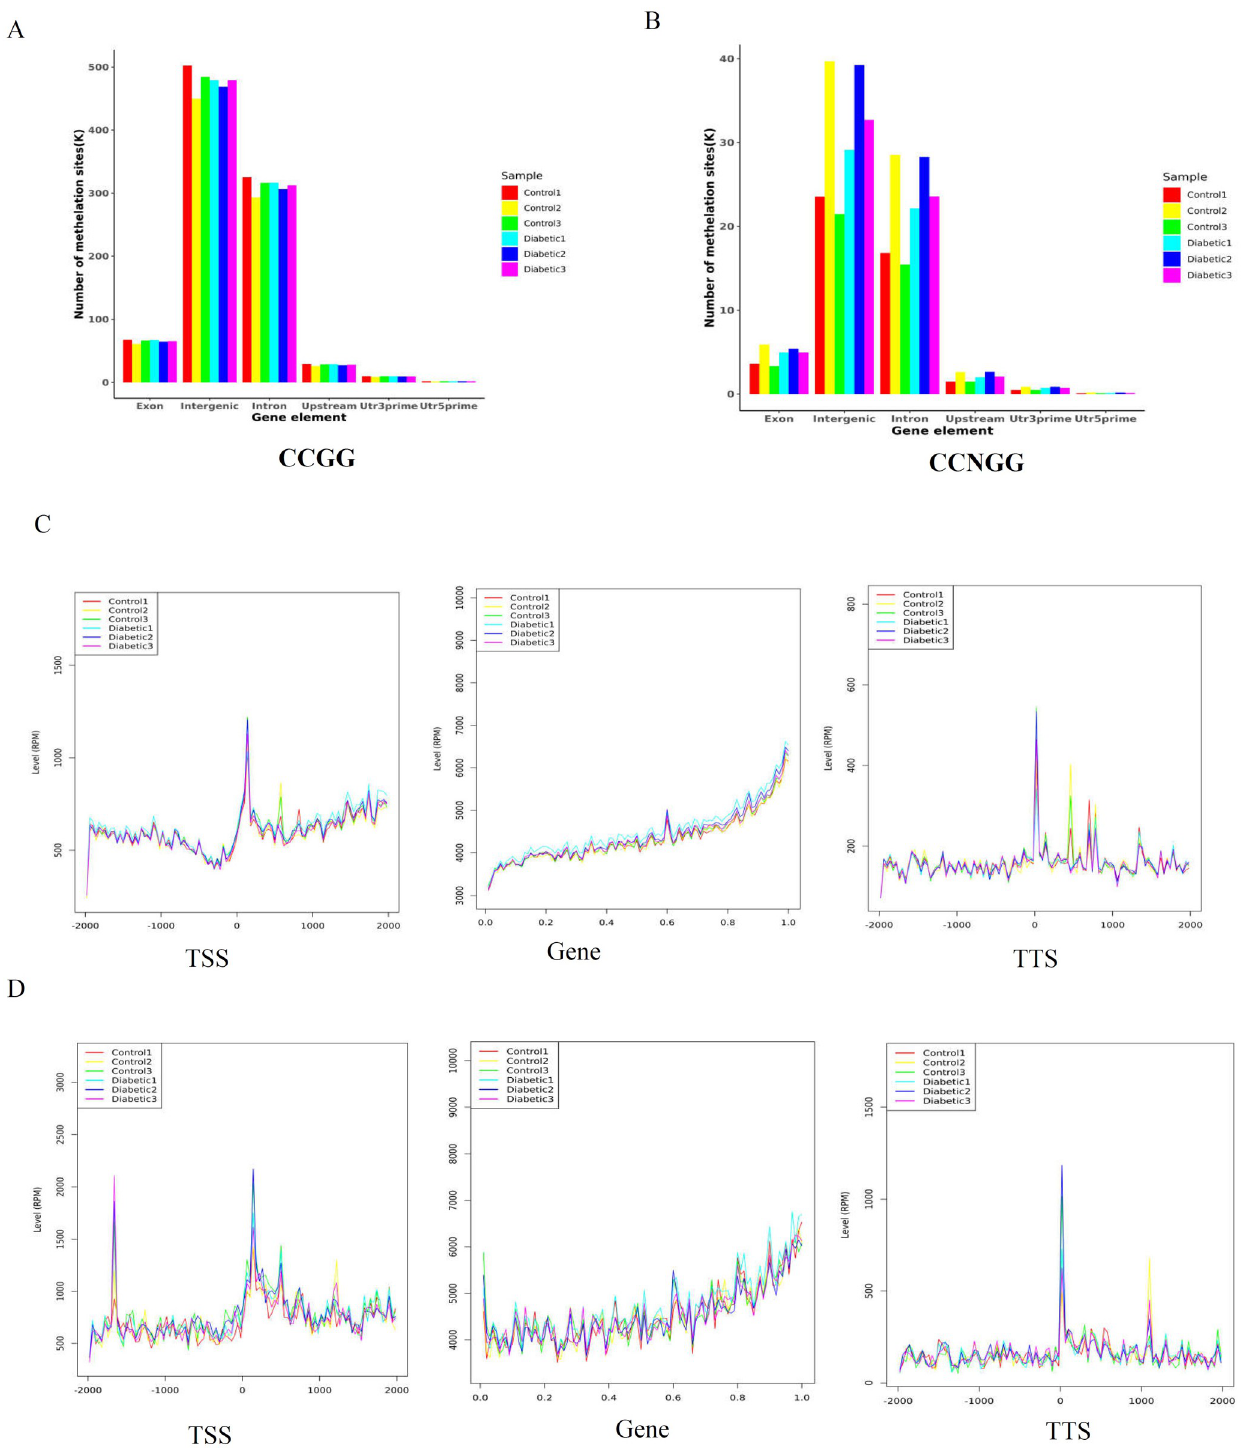
Fig 2. Distribution of DNA methylation sites in different functional regions. (A) CCGG methylation sites on different gene function components distribution histogram (B) CCNGG methylation sites on different gene function components distribution histogram. The y-axis shows the number of methylation sites. The x-axis shows the different components of the genome. (C) Distribution of CCGG methylation sites around gene bodies. The x-axis indicates the position around gene bodies, and the y-axis indicates the normalized read number. (D)Distribution of CCNGG methylation sites around gene